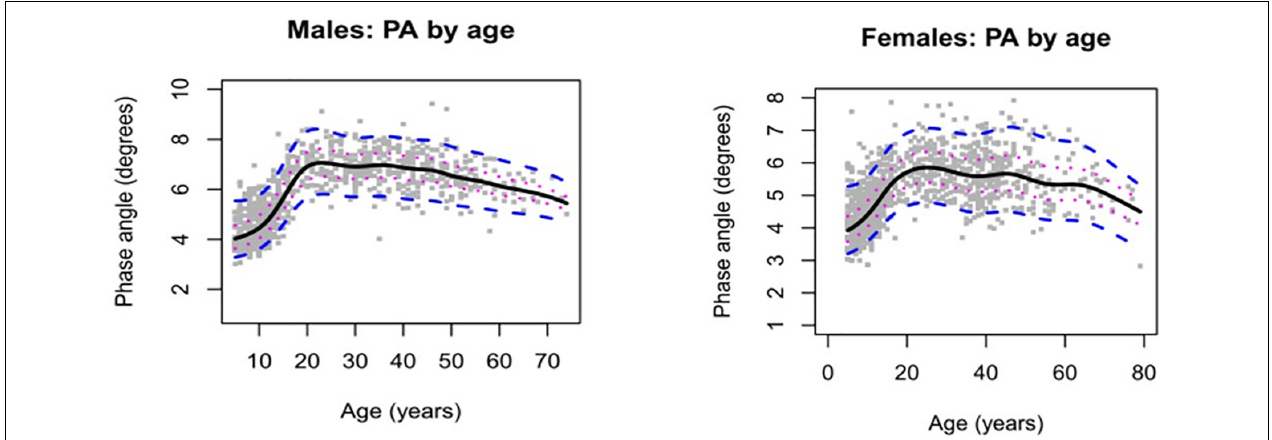
FIGURE 1 | Phase angle by age in healthy males’ and female’s individuals. Solid lines represent median estimates together with 25th and 75th centiles (dotted lines) and 5th and 95th centiles (dashed lines).